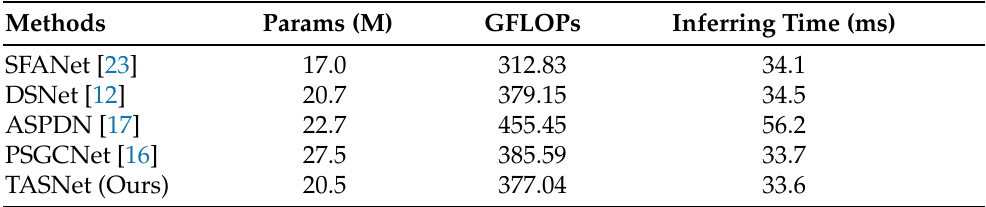
Table 7. Comparison results of the TASNet and other models in parameters, GFLOPs and inferring time. The input size is set to 1024 × 768.